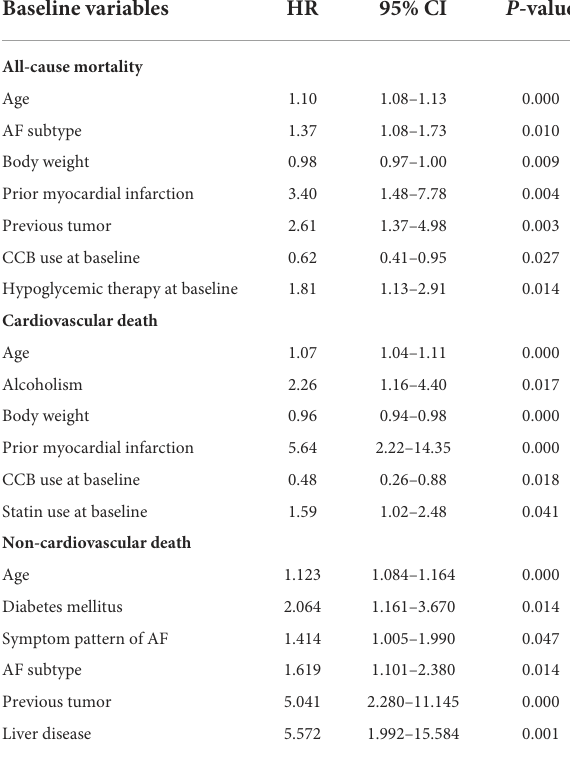
TABLE 3 Independent predictors for all-cause mortality and deaths of specific causes in patients with atrial fibrillation (cox proportional hazard model, multivariate analysis).